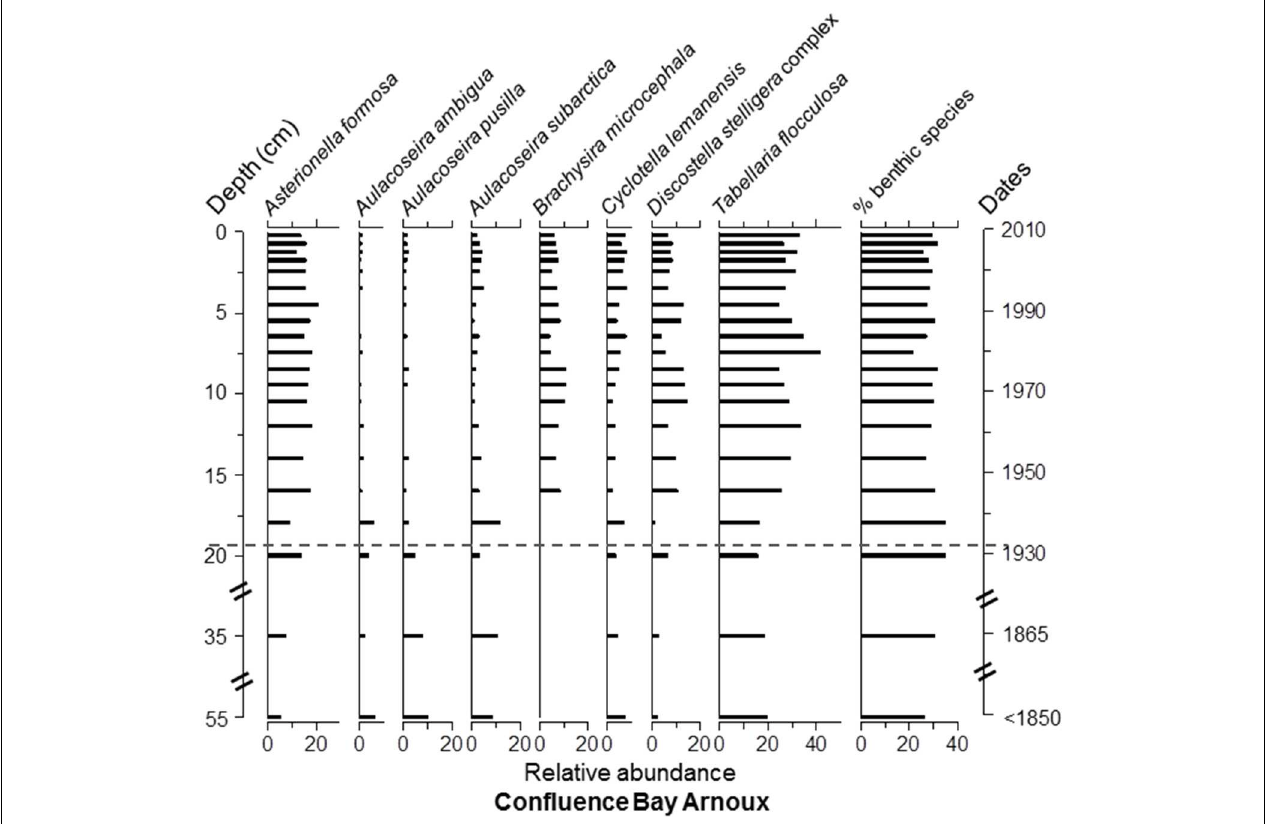
Figure S1 and Data Sheet 1 and Figures 6 – 8 ), whereas Frustulia saxonica and Pinnularia subcapitata var. elongata dominated